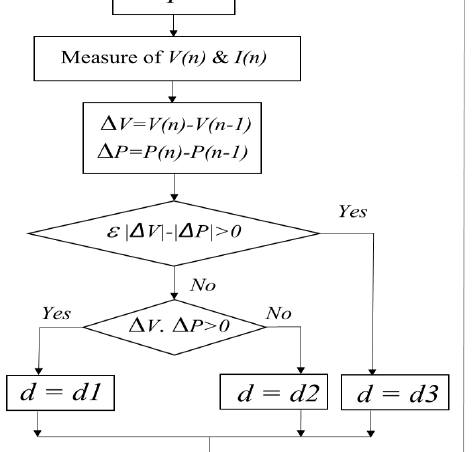
Figure 9: The first part of the"INC_AM" algorithm